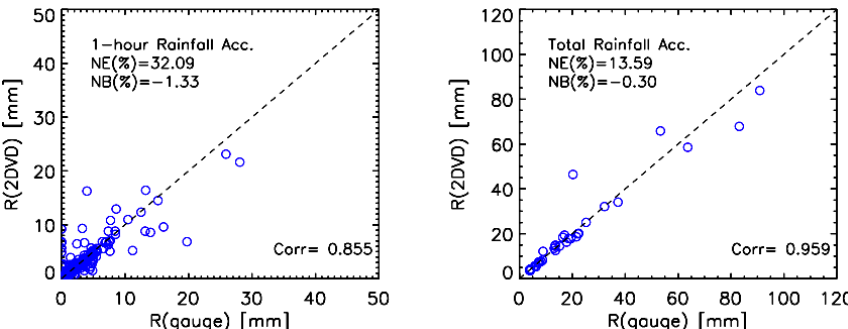
Figure 4. One-hour (left panel) and total accumulated rainfall (right panel) from the 2DVD and rain gauge for the 33 rainfall